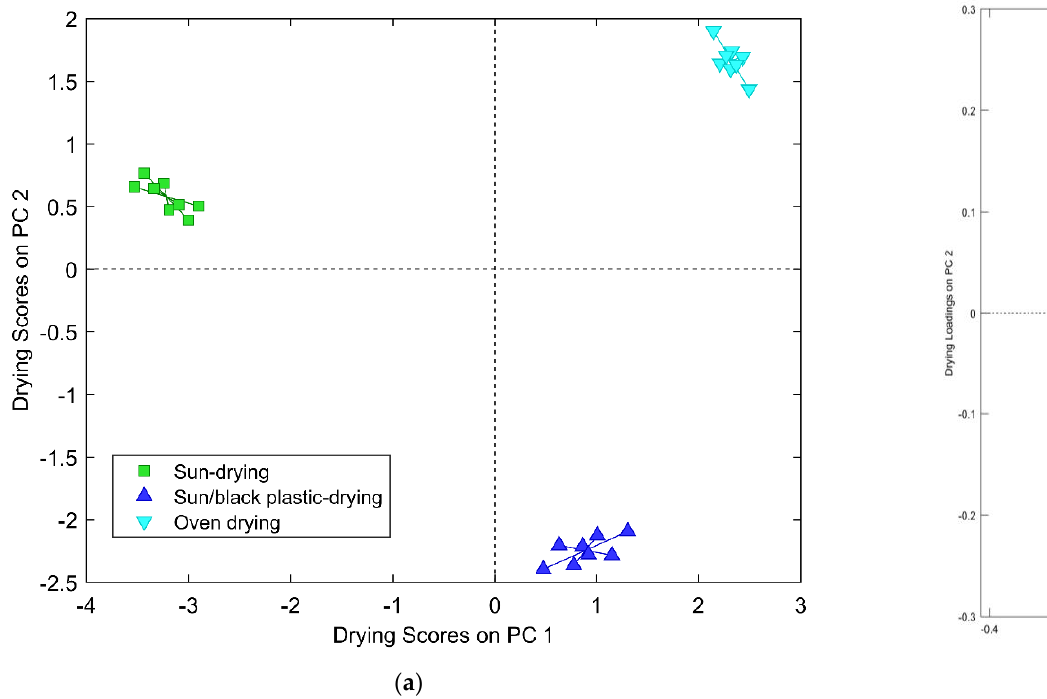
Figure 4. Scores ( a ) and loadings ( b ) plot on Principal Components 1 and 2 of the ASCA performed to evaluate the main effect of drying using the volatile content of cocoa submitted to sun drying, a modification using a black plastic on a concrete floor, and oven drying.